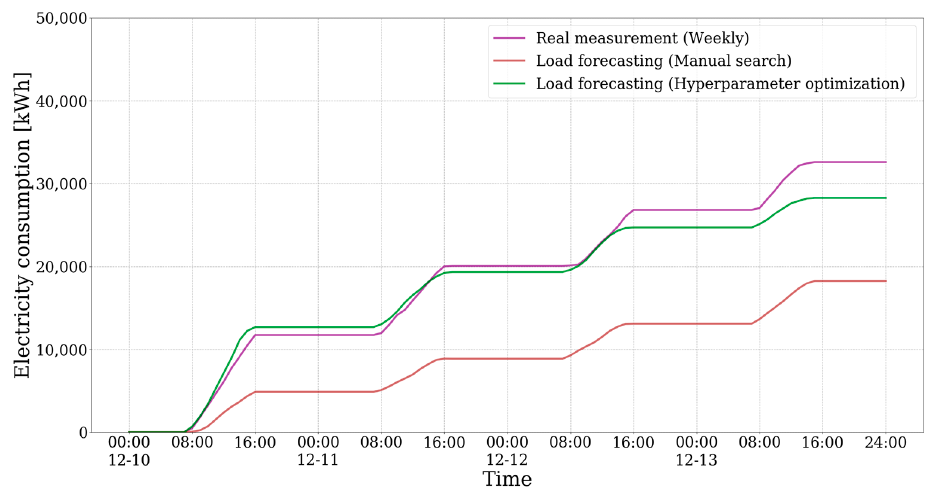
Figure 14. Load forecasting result with weekly model and building data. Table 6. Error for test data with simulation data.